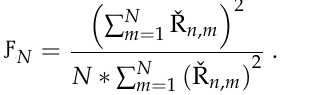
Figure 1. System Model.